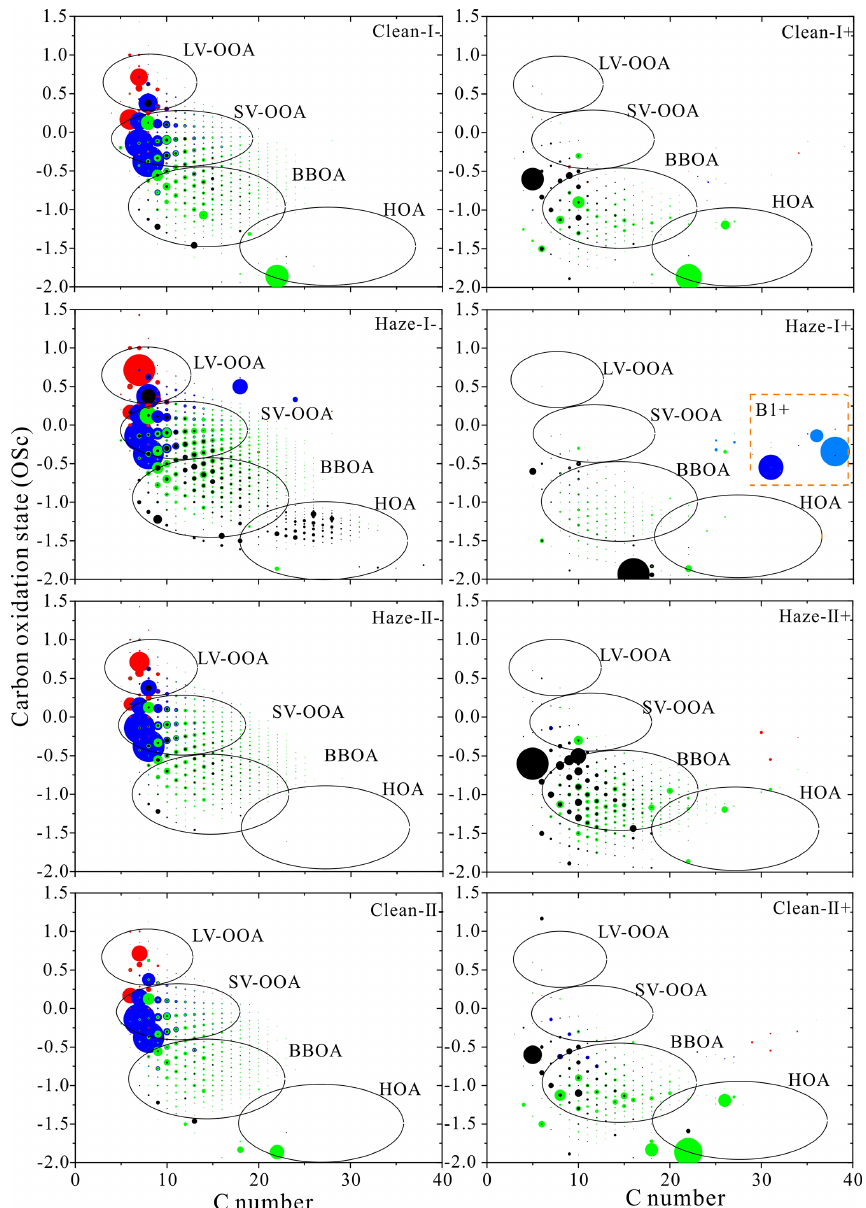
Figure 4. Carbon oxidation state (OS C ) plots for CHON − and CHON + . Formulas with black, green, blue, and red are assigned to aliphatic (AI = 0), olefinic (0 < AI < 0 . 5), aromatic (0 . 5 ≤ AI < 0 . 67), and condensed aromatic (AI ≥ 0 . 67) species (Koch and Dittmar, 2006), re-